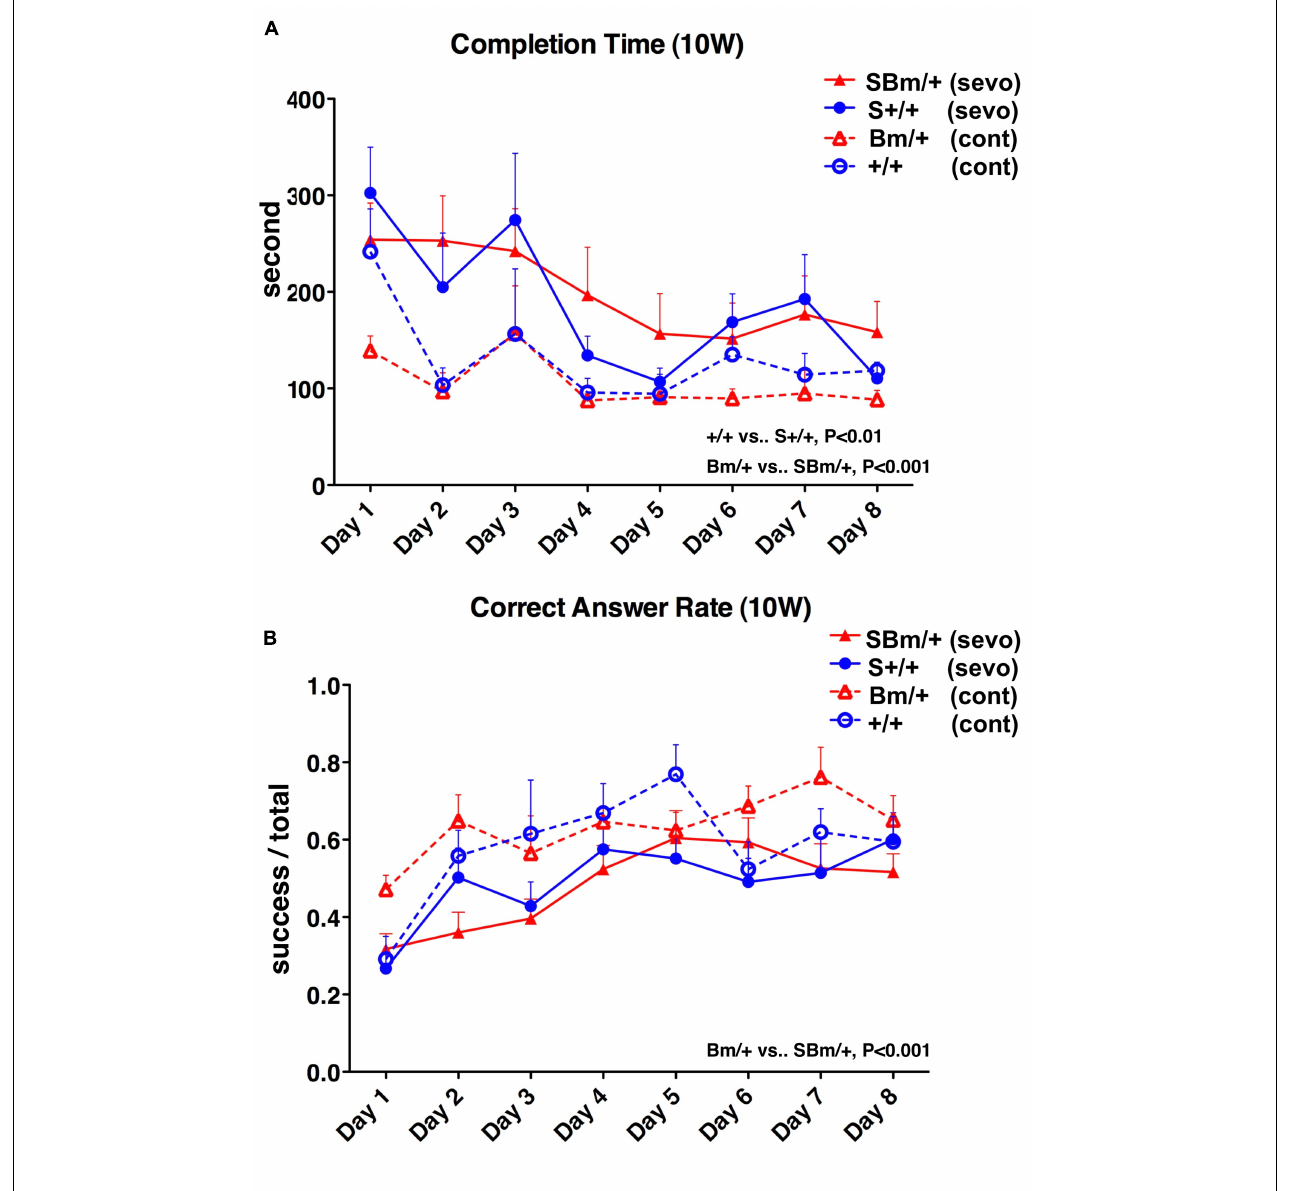
FIGURE 4 | Exposure to inhalational anesthetics had more negative effects on spatial working memory in young mutant BiP mice at 10 weeks. Eight-arm radial maze testing was performed in wild-type mice (+/+; blue lines) and mutant-BiP mice (Bm; red lines) at 10 weeks after fetal anesthetic sevoflurane (S) exposure (S+/+, n = 12, closed circle; SBm, n = 16, closed triangle) and without exposure (+/+, n = 6, open circle; Bm, n = 8; open triangle). Tests were performed over 8 days. Significance was determined by one-way repeated measures ANOVA followed by Bonferroni’s multiple comparison testing. (A) Completion times are the average of each group + SEM. ANOVA, P < 0.0001; +/+10 weeks vs. +/+ S 10 weeks, P < 0.01; Bm/ + 10 weeks vs. SBm/ + 10 weeks, P < 0.001. (B) Correct answer rates are shown as the average value of each group + SEM. The ratio of successful attempts to overall attempts was the correct answer rate (0.0–1.0). ANOVA, P = 0.0002; +/+10 weeks vs. +/+S10 weeks, not significant; Bm/ + 10 weeks vs. SBm/ + 10 weeks, P <